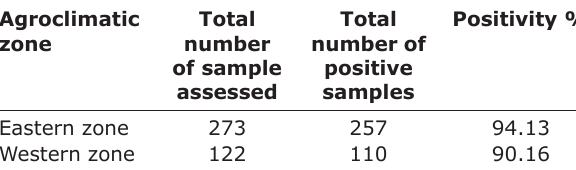
Table-4: Agroclimatic zone-wise BTV seroprevalence in buffaloes of Haryana as assessed by c-ELISA.